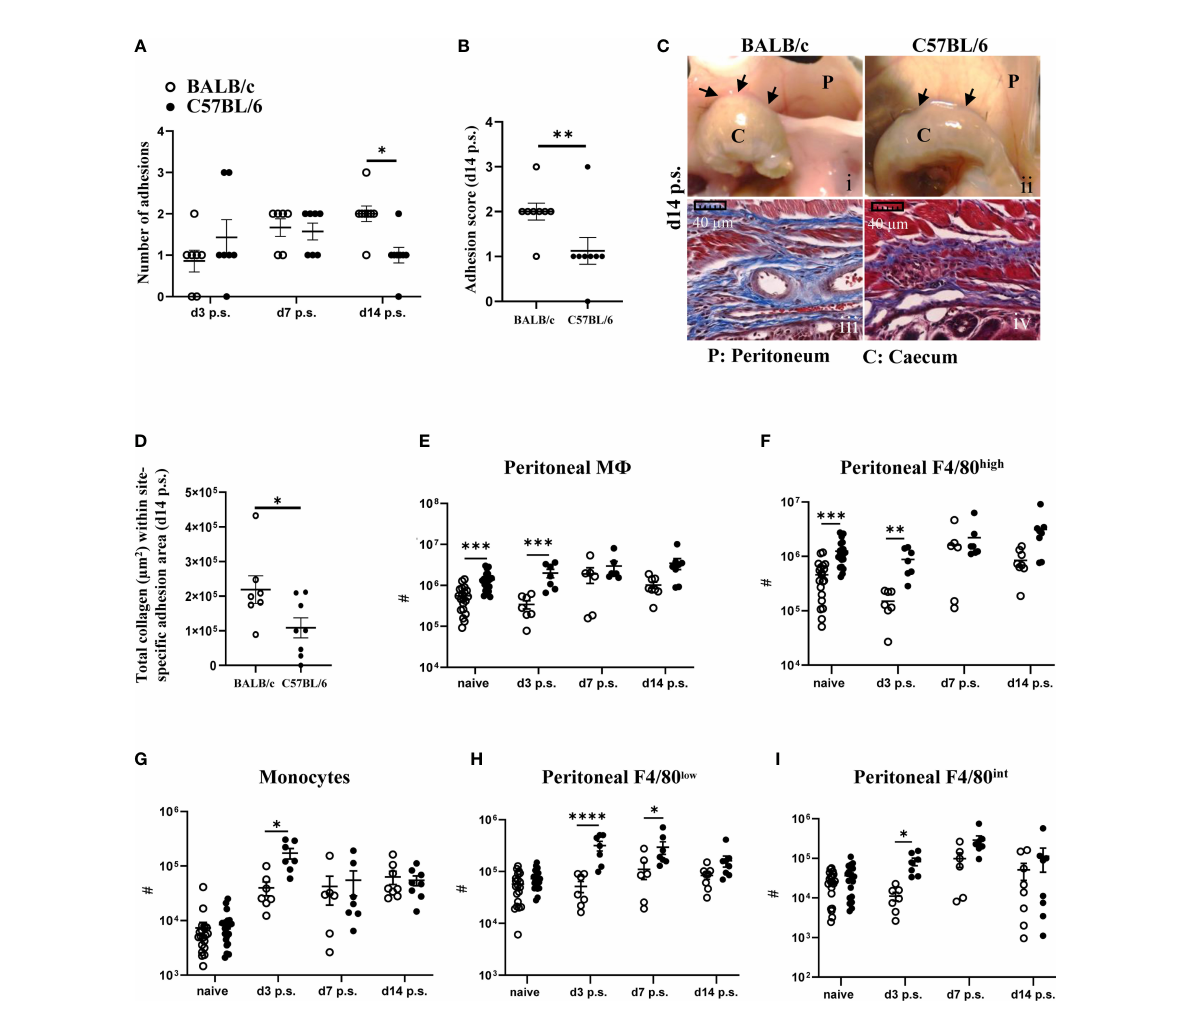
FIGURE 1 BALB/c mice showed more peritoneal adhesions than C57BL/6 mice at day 14 post-surgery (p.s.), and fewer monocytes and macrophages at day 3. Number of adhesions after surgery at different time points (A) and adhesion score at day 14 post-surgery (B) . Representative image and corresponding histological appearance (Masson ’ s trichrome staining) of adhesions between mouse strains at day 14 after surgery (C) . Collagen analysis in adhesion histological sections at day 14 post-surgery (D) . Total cell number of total peritoneal cavity macrophages (E) , peritoneal resident macrophages (F) , monocytes (G) , peritoneal F4/80 low macrophages (H) and peritoneal F4/80 int intermediate macrophages (I) . Data shows mean ± SEM, pooled from 6 separate experiments for naïve or 2 separate experiments for day 3, 7, and 14 post-surgery., n= 6-20 mice/ group; * P <0.05, ** P <0.01, *** P <0.001, **** P <0.0001. (A) ANOVA with Sidak ’ s multiple comparison test; (B, C) Mann Whitney test and (E – I) ANOVA with Tukey ’ s multiple comparison test. Scale bar: 40 m